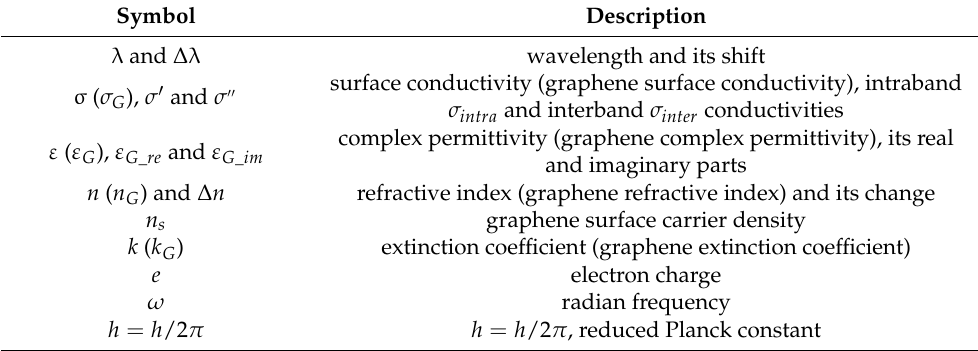
Table 1. The list of symbols and notations. Symbol Description λ and ∆ λ wavelength and its